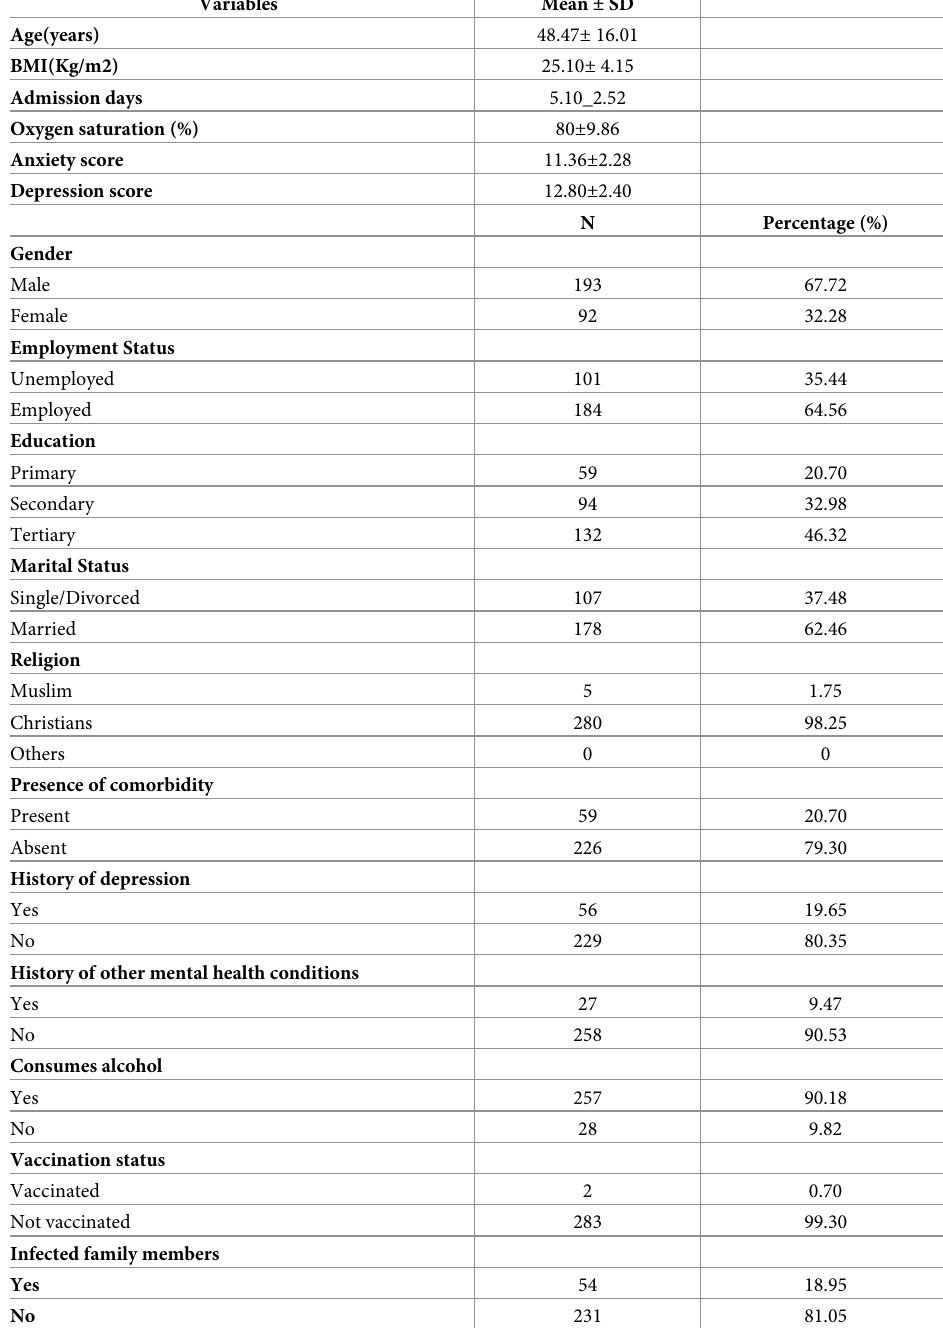
Table 1. Sociodemographic characteristics of